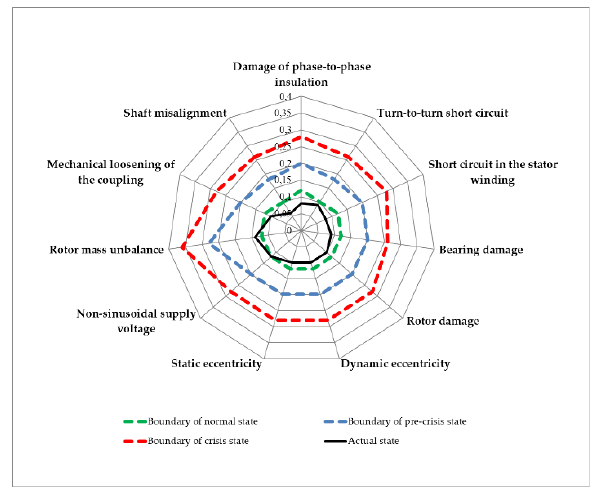
Figure 6. Graph for probabilistic normal state of the unit.